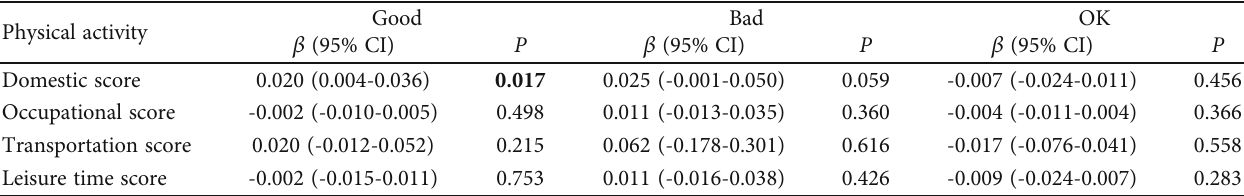
Table 4: The association between physical activities and cognitive function in people with di ff erent memory